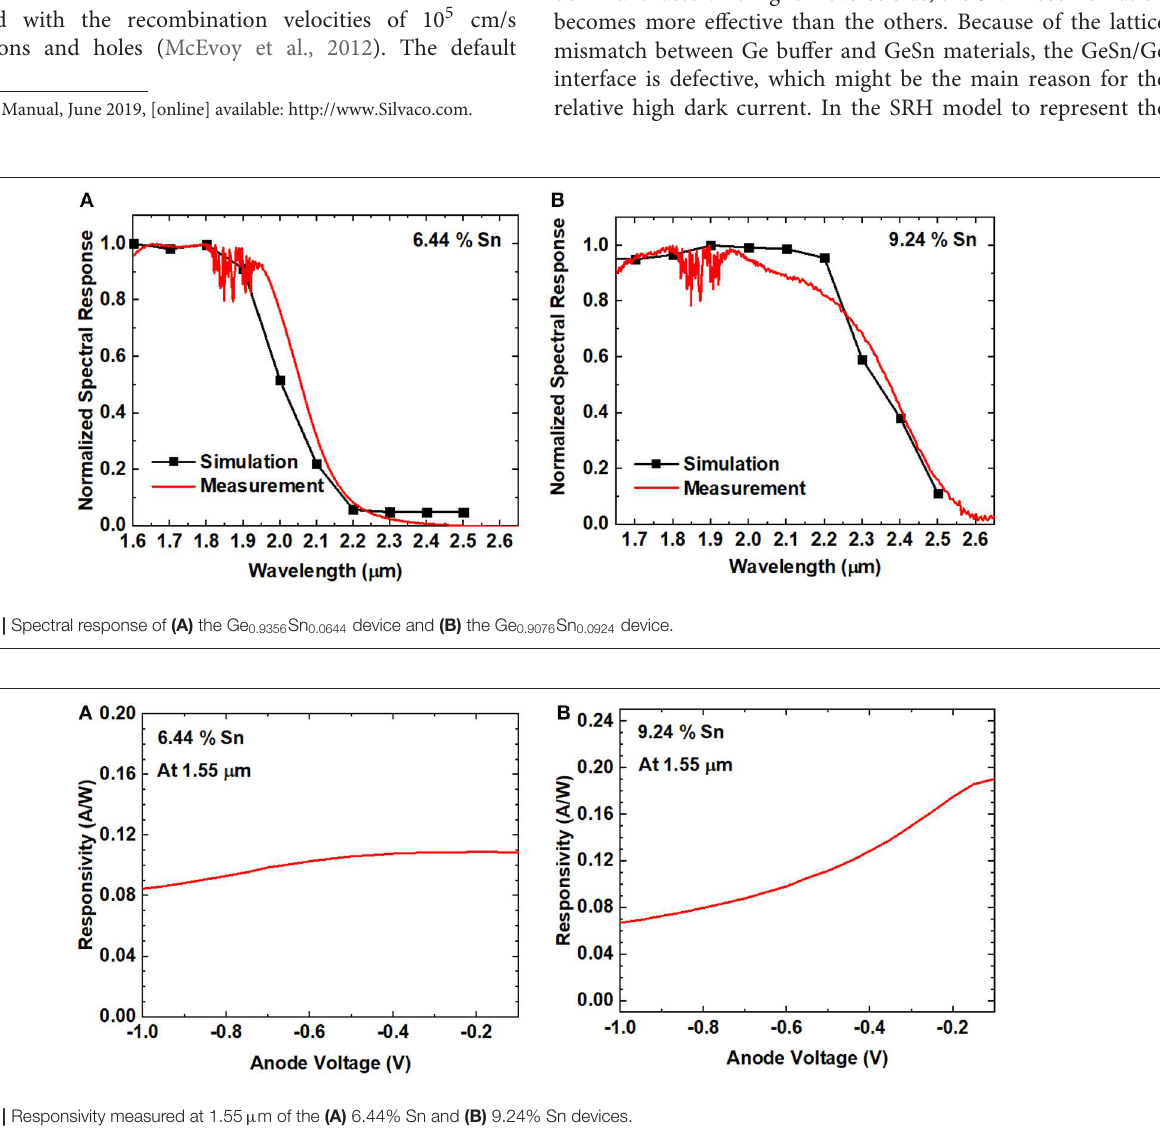
Frontiers in Materials |